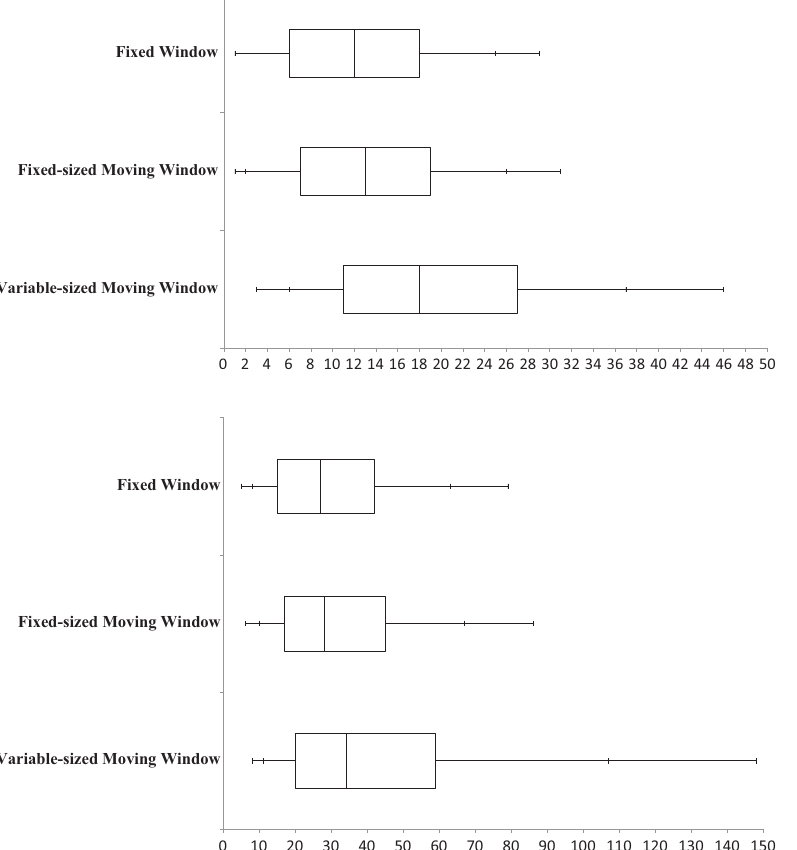
Figure 3. Out-of-control distribution of the conditional ARL of the EWMA P 11 -chartwhen m 5 500, λ 5 0.05, and